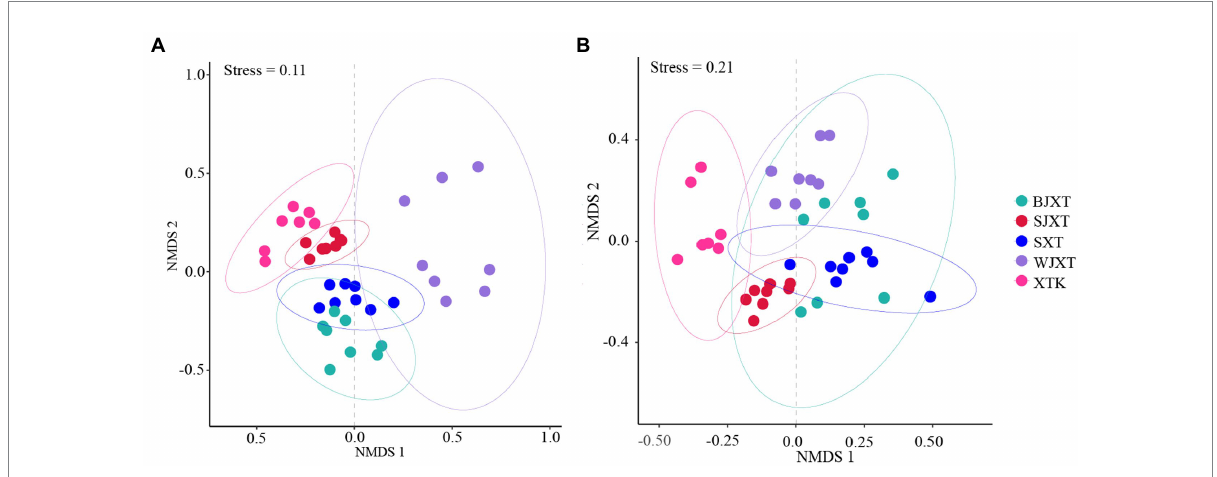
FIGURE 2 The non-metric multidimensional scaling (NMDS) analysis of bacterial (A) and fungal (B) communities in five karst tiankengs. BJXT: Bajiaxiantang, SJXT: Shaojiaxiantang, SXT: Shenxiantang, WJXT: Wangjiaxiantang, XTK: Xiaotiankeng.